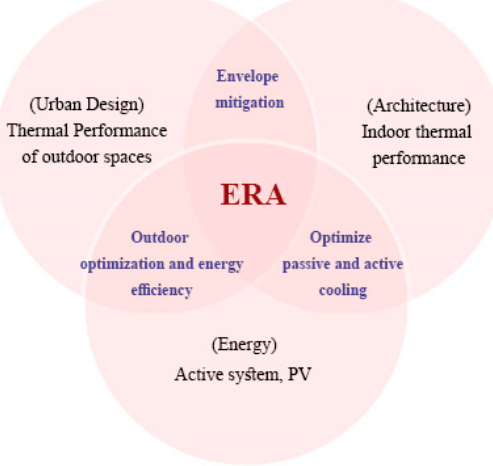
Figure 8. ERA Tripling Evaluation Methodology, TEM.